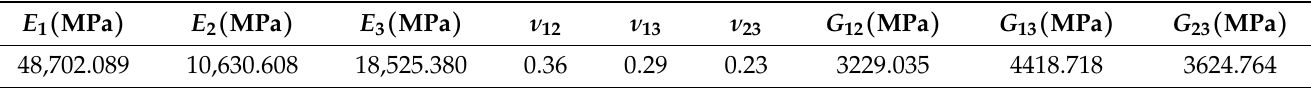
Table 3. Homogenized engineering constants of mesoscopic carbon fiber